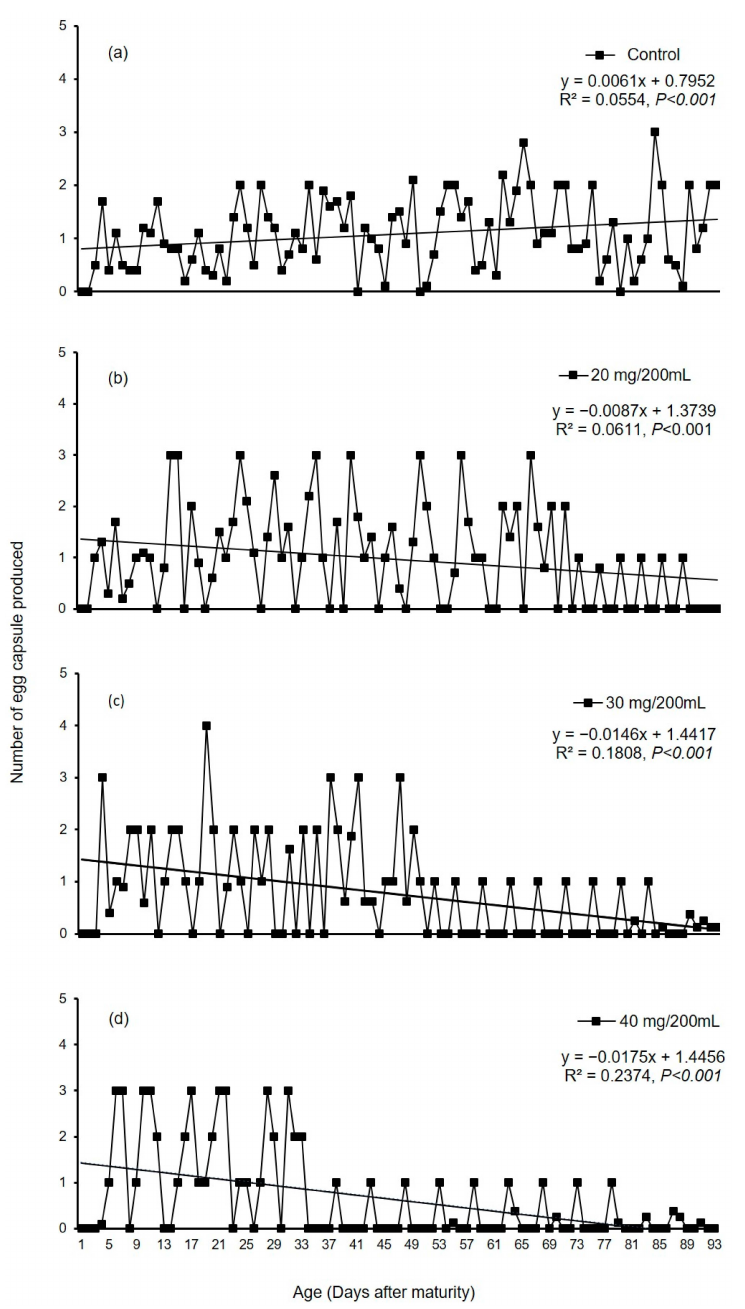
Figure 7. Age-specific egg capsule production in P. acuta ( n = 10), in ( a ) control (without Ms), and in the medium applied with three concentrations of ( b ) 20, ( c ) 30 and ( d ) 40 mg/200 mL of Ms. (b) Egg hatching success and Embryonic development The detailed analyses of the number of eggs in each egg capsule and juveniles hatched in the control and the treatments showed differential results. The cumulative number of hatched juveniles produced from all the eggs recorded during experimental duration were significantly lower in the treatments than in the control ( p < 0.01; one-way ANOVA, followed by Dunnett’s T3 test) (Figure